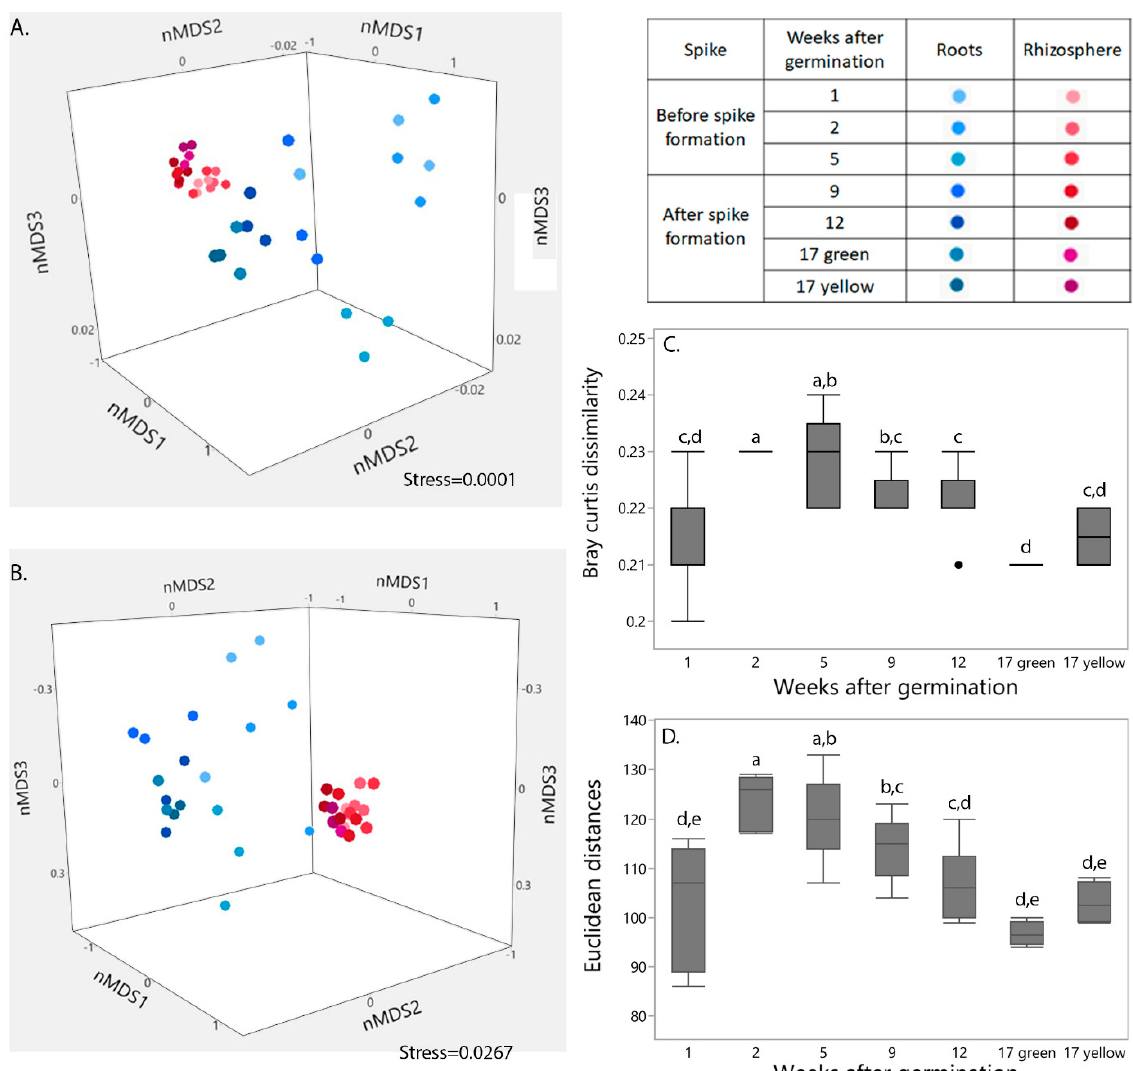
Figure 1. Shifts in root-associated and rhizosphere bacterial community structure and function with plant age. nMDS ordination plots show clustering patterns of wheat root-associated and rhizosphere microbial community structures ( A ) and functions ( B ) during wheat growth. Data matrix was transformed using normalized count transformation in the DESeq2 package, and then ordination was generated using Bray-Curtis dissimilarity and Euclidean distances, respectively. ( C ) Changes in structural and ( D ) functional similarity between wheat root-associated and rhizosphere microbial communities at each week. Different lowercase letters indicate significant difference ( p < 0.05) by Student’s t -test. Weeks 1, 2, 5, 9 and 12: n = 6; week 17 green (green spike) and yellow (yellow spike): n = 2 for each. A black dot in Figure 1C, indicate the outlier at week 12.